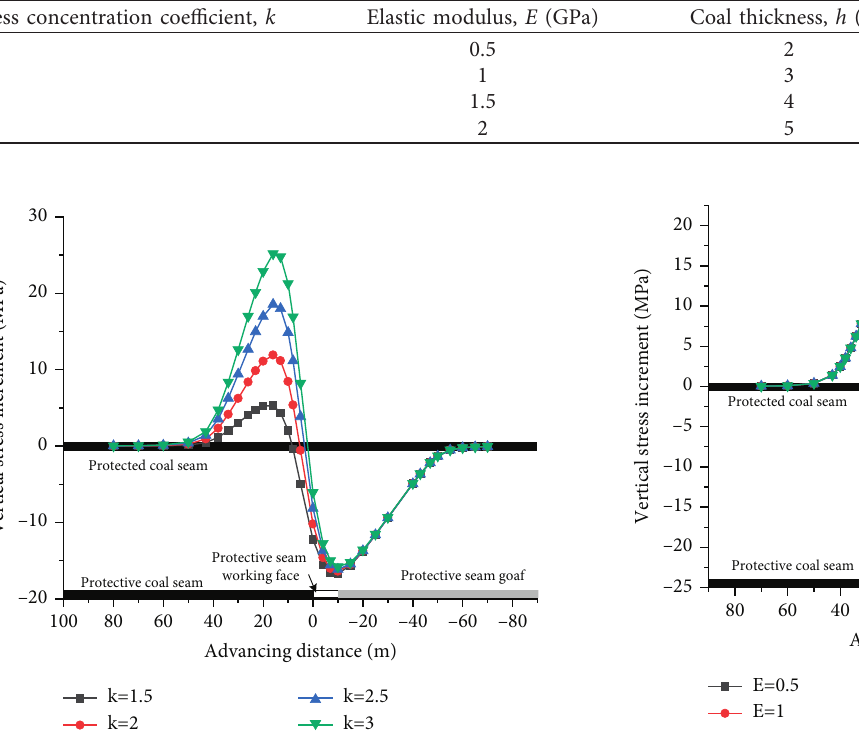
Table 1: Values of different influencing factors.